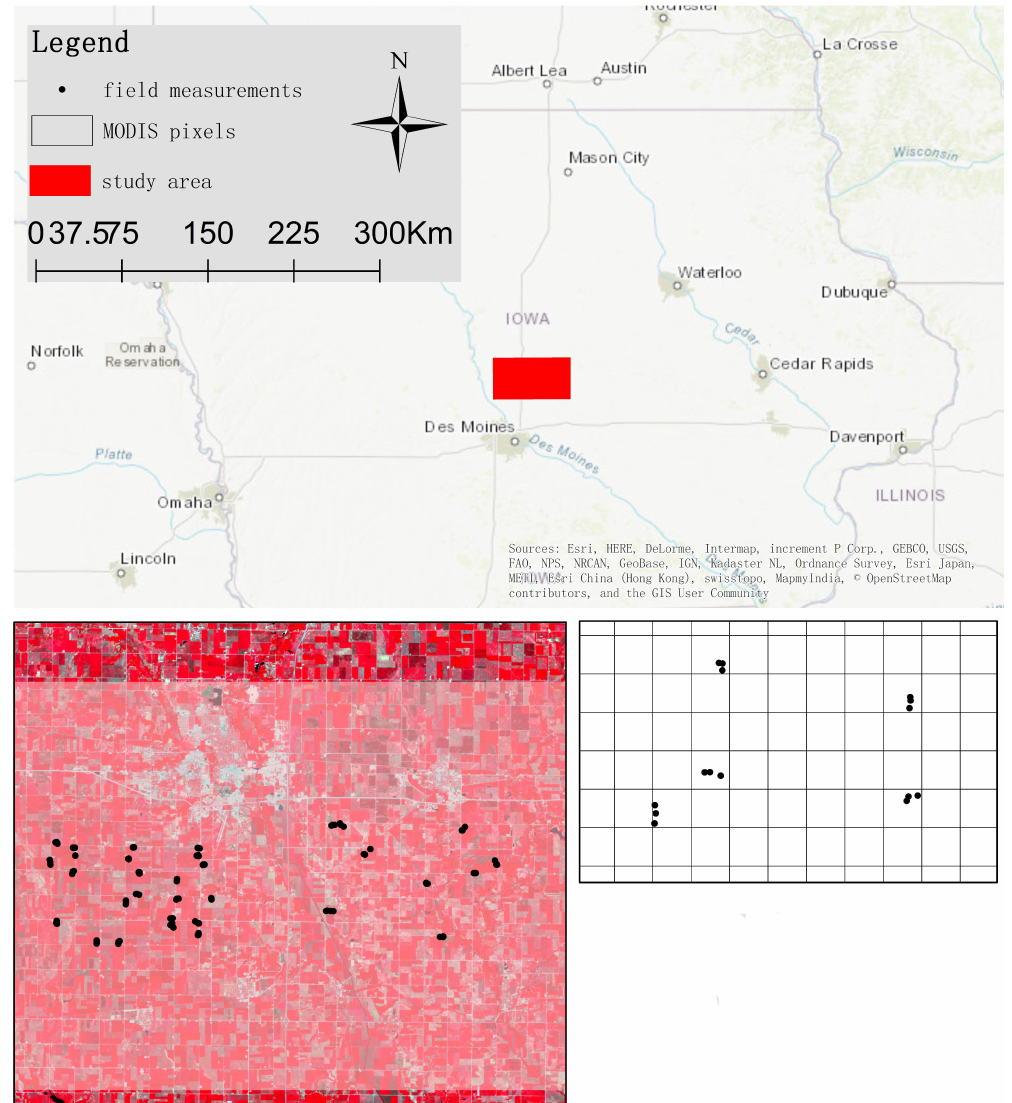
Figure 2. The two study areas: ( a ) Baoding, Hebei Province, China; ( b ) Des Moines, Iowa, United States. The grid in ( b ) shows the MODIS pixel cells at the 500-m